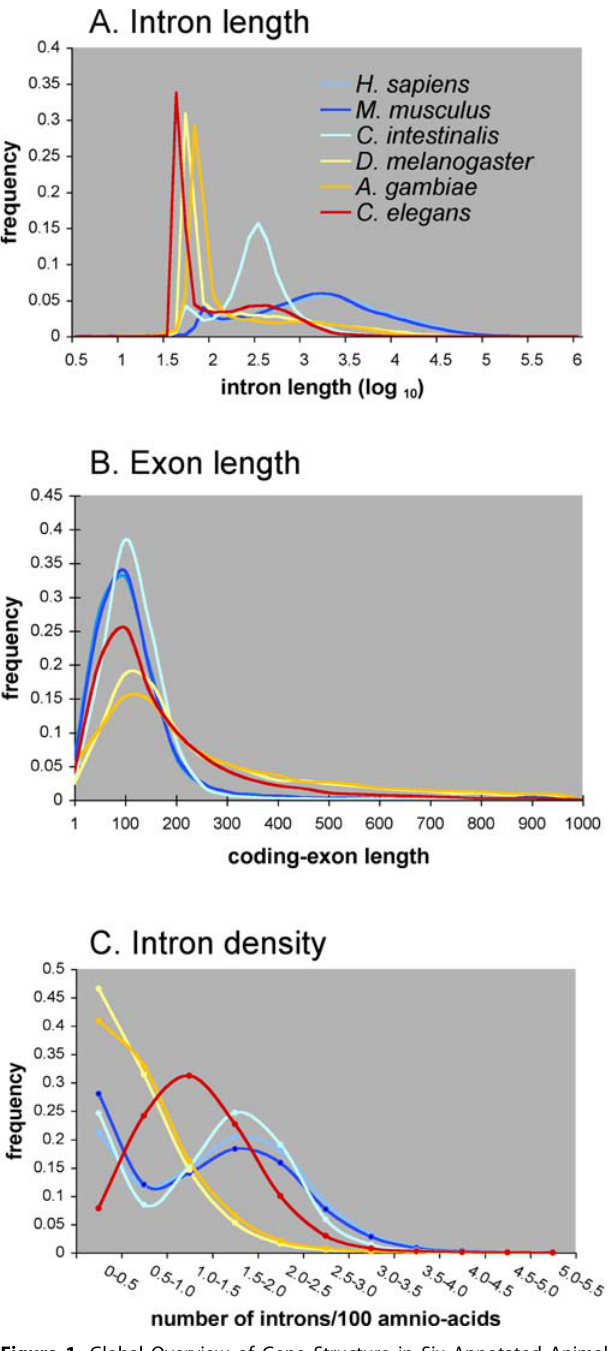
Figure 1. Global Overview of Gene Structure in Six Annotated Animal Genomes (A) Intron length. Annotated intron length (log 10 ) is plotted on the x -axis; the frequency at which introns of that length occur in an organism’s genome is plotted on the y -axis. (B) Exon length. x -axis, coding-exon length in nucleotides; y -axis, frequency. (C) Intron density. A transcript’s intron density is equal to its number of coding introns divided by the length of the protein it encodes. y -axis, frequency of annotated transcripts with a particular intron density. x -axis, intron density binned in increments of 0.5 introns/100 amino acid (see Materials and Methods). Deuterostomes are shown in shades of blue; protostomes in shades of red. DOI: